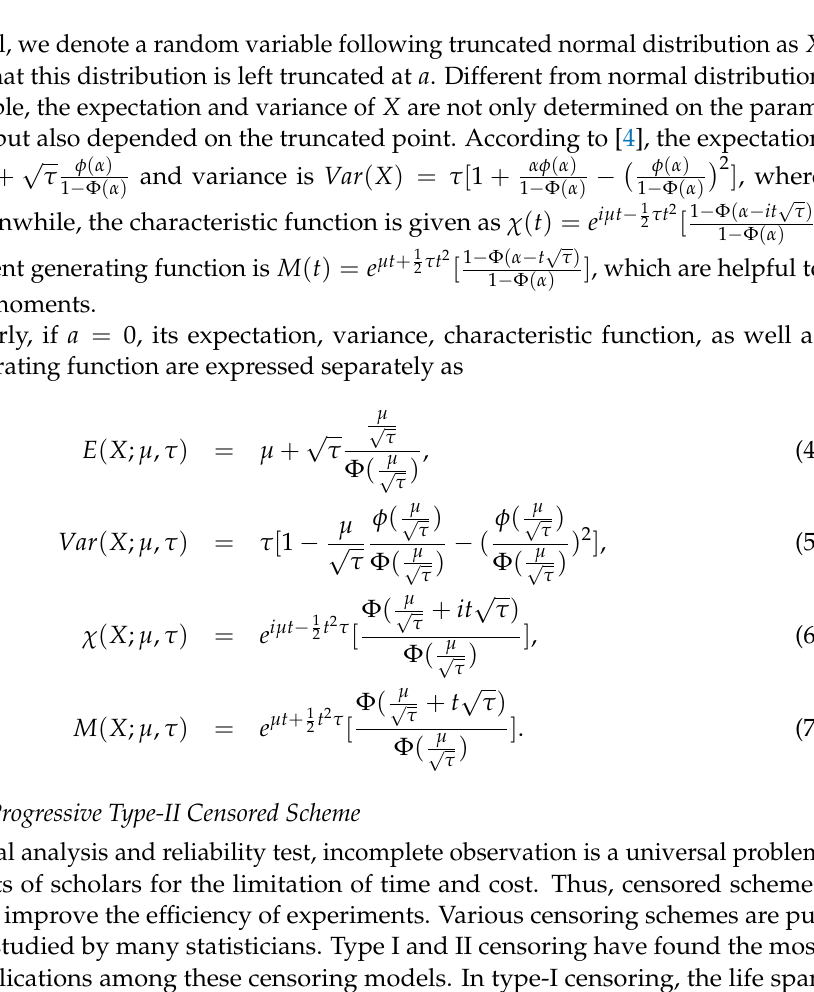
Figure 2. Cdf of truncated normal